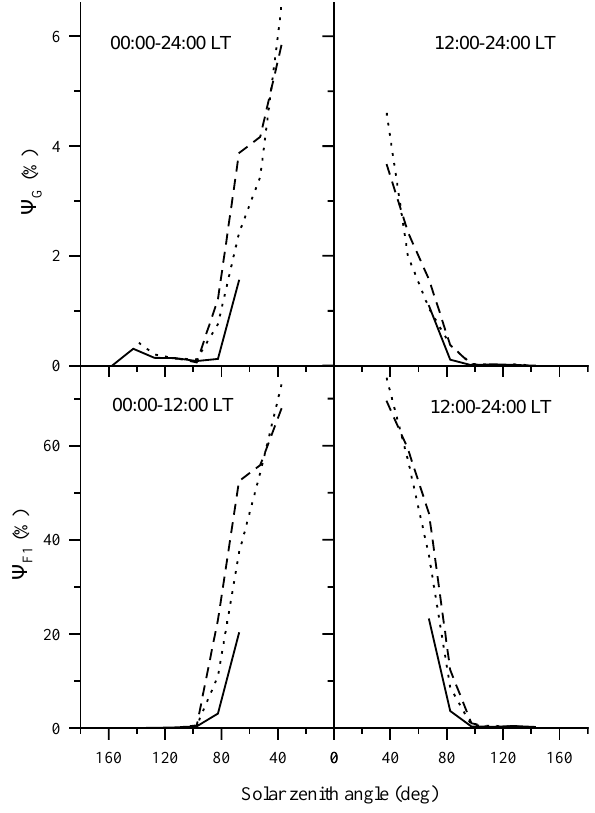
Fig. 5. The dependence of the F1-layer (bottom panels), and G con- dition (top panels) probability functions on the solar zenith angle in latitude range 5 (60 ◦ < | 8 | ≤ 90 ◦ ) during the winter (solid lines), summer (dashed lines), and spring and autumn (dotted lines) months before midday from 00:00LT to 12:00LT (left panels), and after midday from 12:00LT to 24:00LT (right panels).